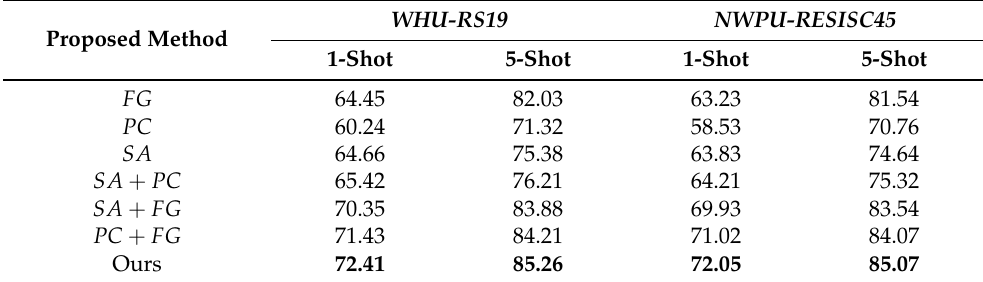
Figure 11. t-SNE visualization of the feature distribution, ( a ) represents the distribution of features in the support set, ( b ) is the visualization of the expand support set with generating 150 features per category, ( c ) is the visualization of the expand support set with generating 500 features per category, and ( d ) denotes the feature distribution of query set. Table 5. Classification accuracy with different composite scenarios tested on NWPU-RESISC45 dataset and WHU-RS19